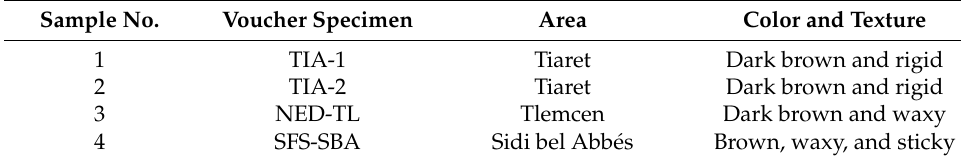
Table 1. Collection areas and properties of the collected propolis samples. Sample